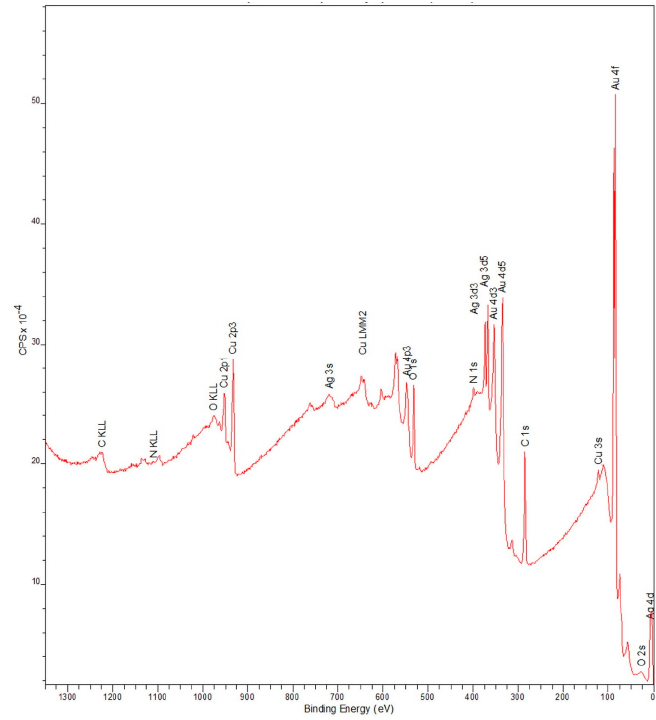
Figure 5. X-ray photoelectron spectroscopy (XPS) spectra for type IV Au alloy.